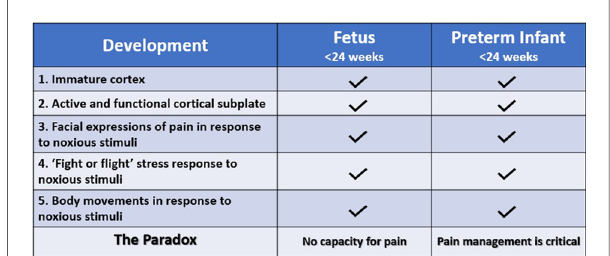
FIGURE 1 The fetal pain paradox. Both the fetus and preterm infant <24 weeks gestation have an immature cerebral cortex (12) and an active, functional cortical sublate (13, 14). Both mount hormonal and hemodynamic stress responses (6, 15) and demonstrate pain-related facial expressions (6, 16) and body movements (6, 15) following noxious stimuli. The standard of care for preterm infants, according to the American Academy of Pediatrics, is pain management utilizing validated pain assessment tools. However, the American College of Obstetricians and Gynecologists (11), the Society for Maternal Fetal Medicine (1), and the Royal College of Obstetricians and Gynaecologists (2) state that pain perception is not possible until after 24 – 28 weeks